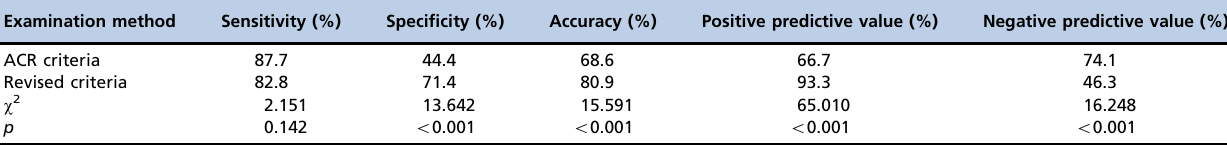
Table 3 - Comparison of the diagnostic performance of the two diagnostic